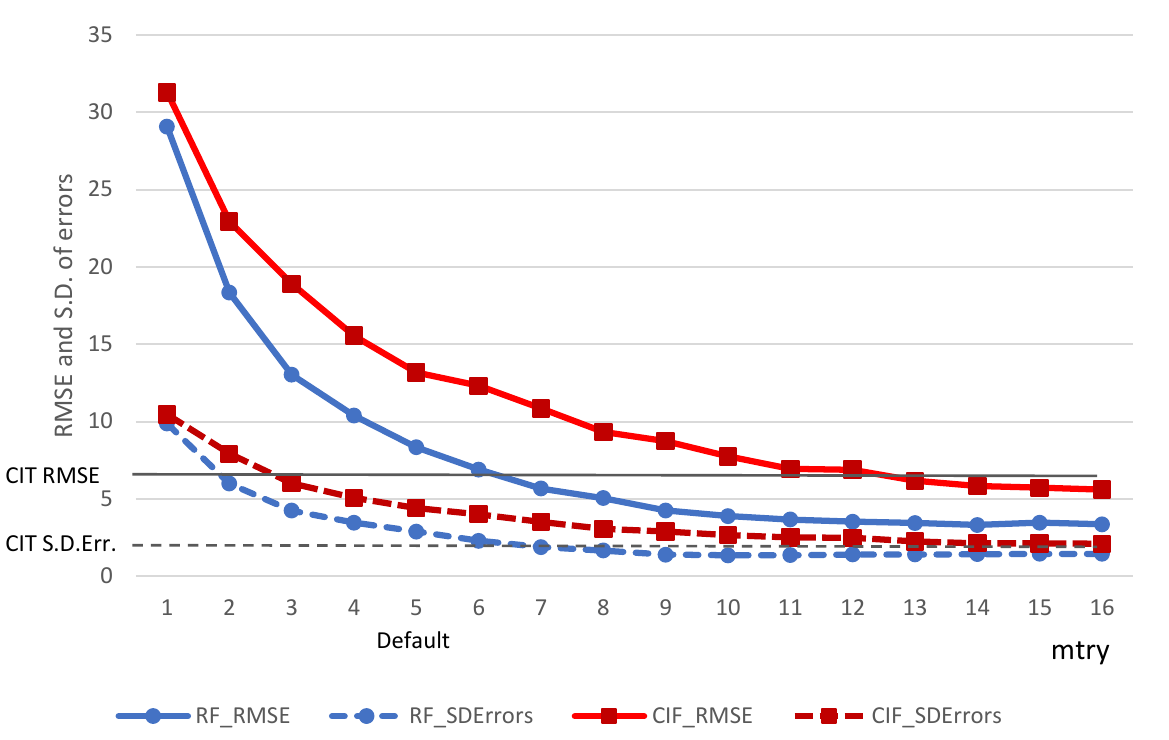
Figure 9. RMSE and standard deviation of errors by RF and CIF algorithms upon the number of bagging features (mtry).